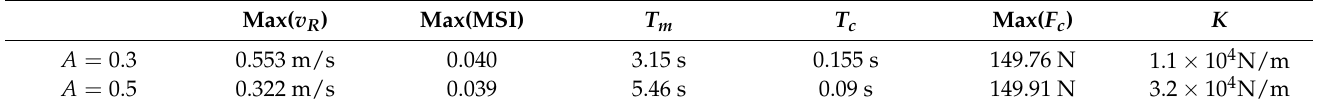
Table 1. The relevant important indicators during the